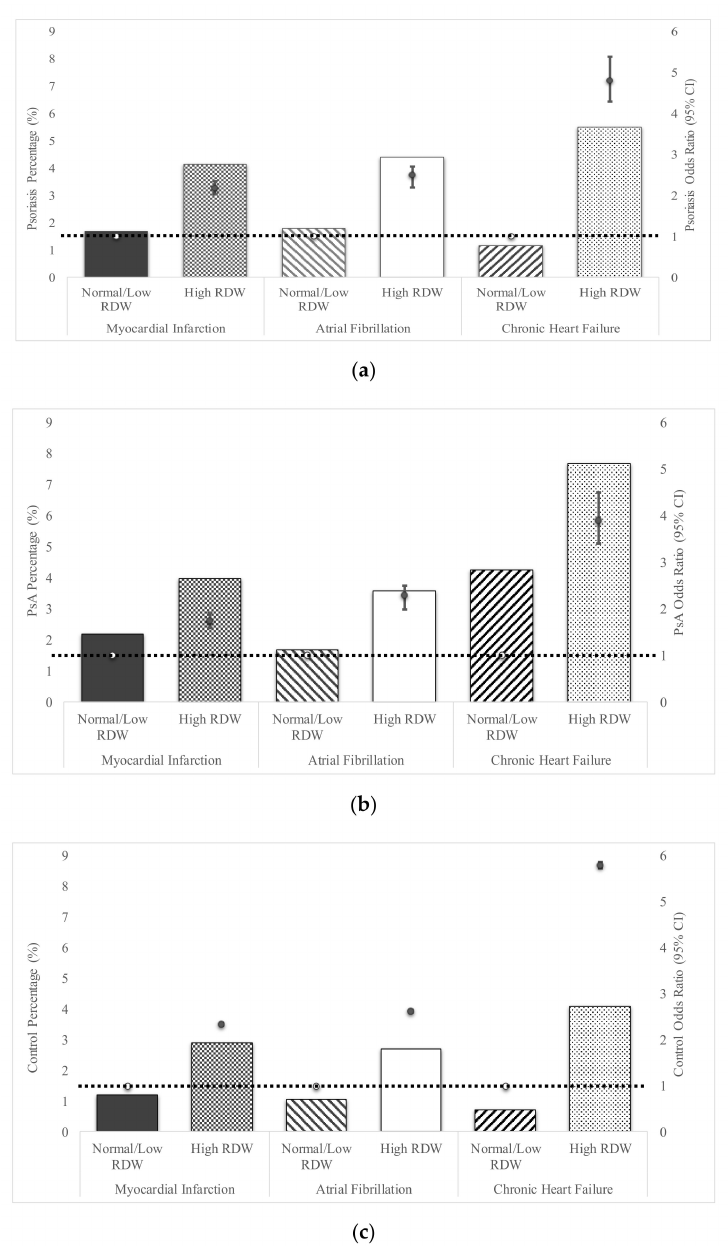
Figure 1. Development of Cardiovascular Disease based on high versus normal red cell distribution width (RDW) for Psoriasis patients, Psoriatic Arthritis patients, and Controls. The frequency and odds ratio of presenting with three distinct types of cardiovascular diseases based upon RDW status (high versus normal / low, as defined by Explorys) is shown for each group. The scale for the percentage of patients (PsO, PsA) or controls exhibiting each combination is demarcated on the left hand side of the graph, while the odds ratios (OR) scale is listed on the right hand side. Odds Ratios were adjusted for age, gender and hypertension. Open circles connected by the dashed line represent the reference value (1) for each OR. Odds Ratios are represented by solid circles and error bars, which represent 95% confidence intervals. The percentage of psoriasis patients ( a ), psoriatic arthritis patients ( b ) or control subjects ( c ) exhibiting either myocardial infarction (MI), arial fibrillation (AF) and chronic heart failure in psoriasis patients based on RDW expression levels is shown. Prediction of odds ratio for development of the three types of heart failure in psoriasis ( a ) psoriatic arthritis ( b ) and controls ( c ) are quantified on the right